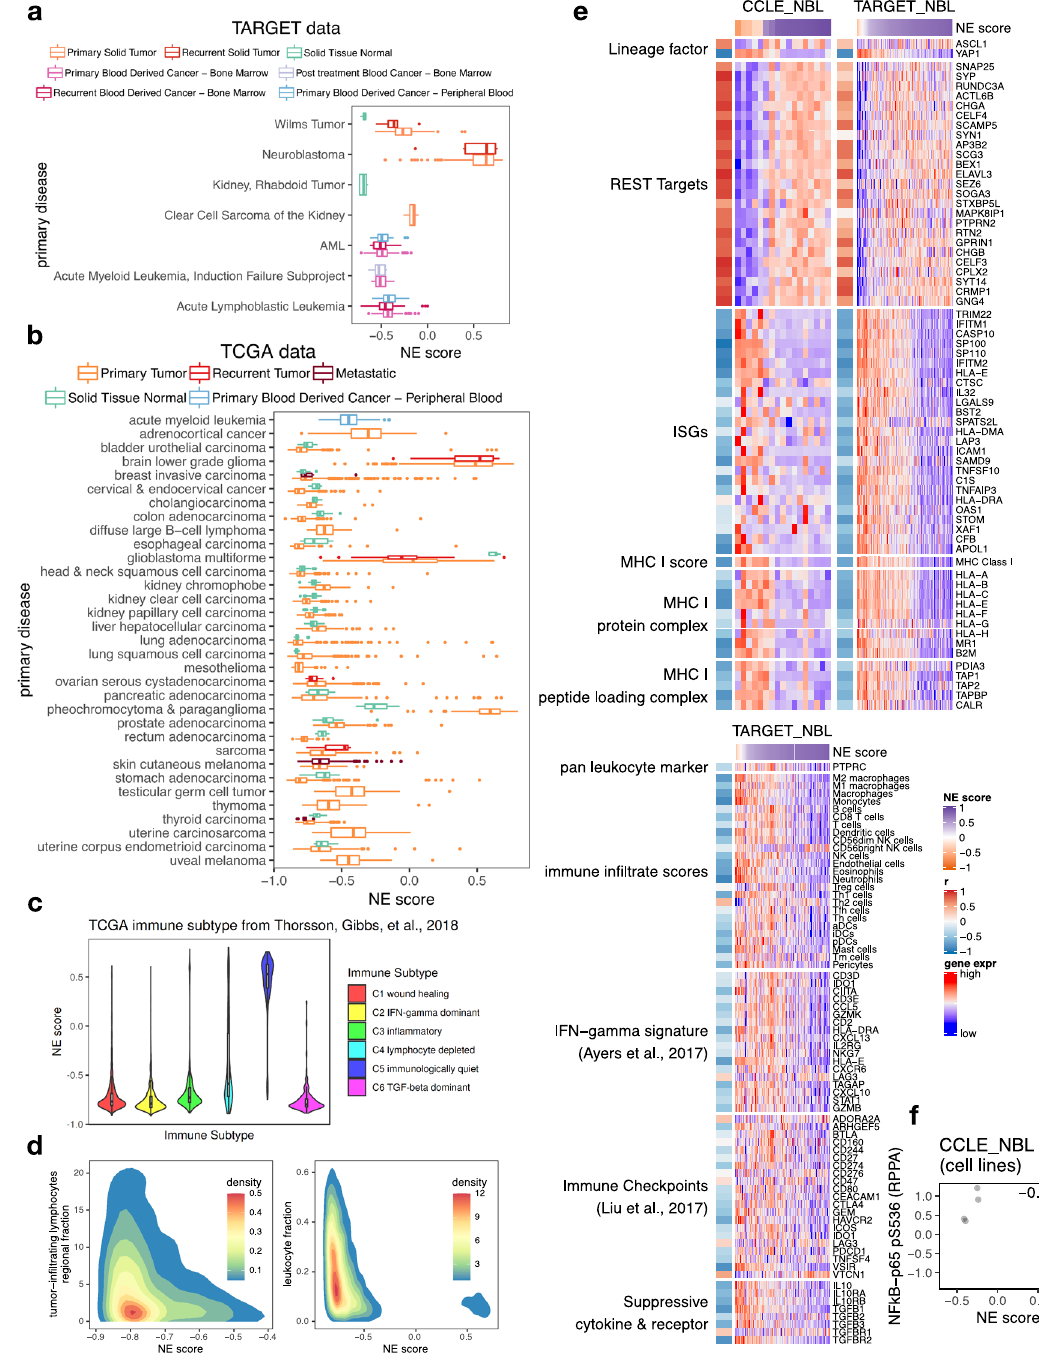
Fig. 5 Relationship between NE scores and immune phenotypes in pan-cancer samples. a , b NE scores of pan-cancer samples in the TARGET pediatric cancer cohorts ( a ) and TCGA adult cancer cohorts ( b ). c NE scores by immune subtype in TCGA pan-cancer samples. d 2D density plots visualizing the relationship between NE scores and tumor-in fi ltrating lymphocytes regional fraction (Pearson correlation coef fi cient − 0.15, p -value < 2.2e − 16) or leukocyte fraction in TCGA pan-cancer samples (Pearson correlation coef fi cient − 0.31, p -value < 2.2e − 16). e Heatmap visualizing expression of various genes and summary scores previously assessed for SCLC and now in NBL with cell line and tumor data sets side-by-side. For each data set, sample-wise z -score standardized values were used. f Scatter plots showing a negative correlation between NE score and Ser536 phosphorylation on NFkB-p65 in NBL cell lines. Pearson correlation coef fi cient was provided. * p -value < 0.05. For all box whisker plots, the centerline represents the median, the lower, and upper hinges correspond to the fi rst and third quartiles, the whiskers extend from the hinge to the value no further than 1.5 * IQR